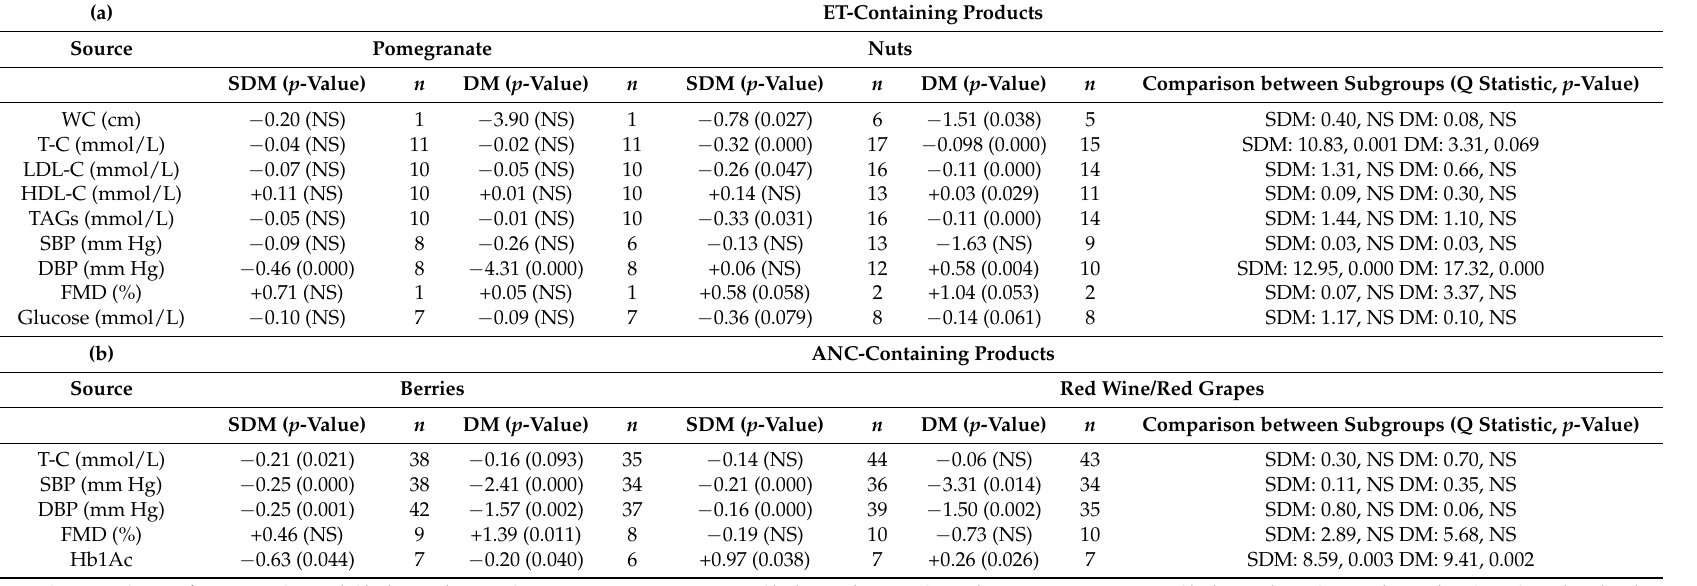
Table 4. Comparative summary of the most significant effects on biomarkers of cardiometabolic risk of: ( a ) the ET-containing products after separation into the two main sources examined: pomegranate vs. nuts; ( b ) the ANC-containing products after stratification by the source of bioactive compounds: berries vs. red wine and red